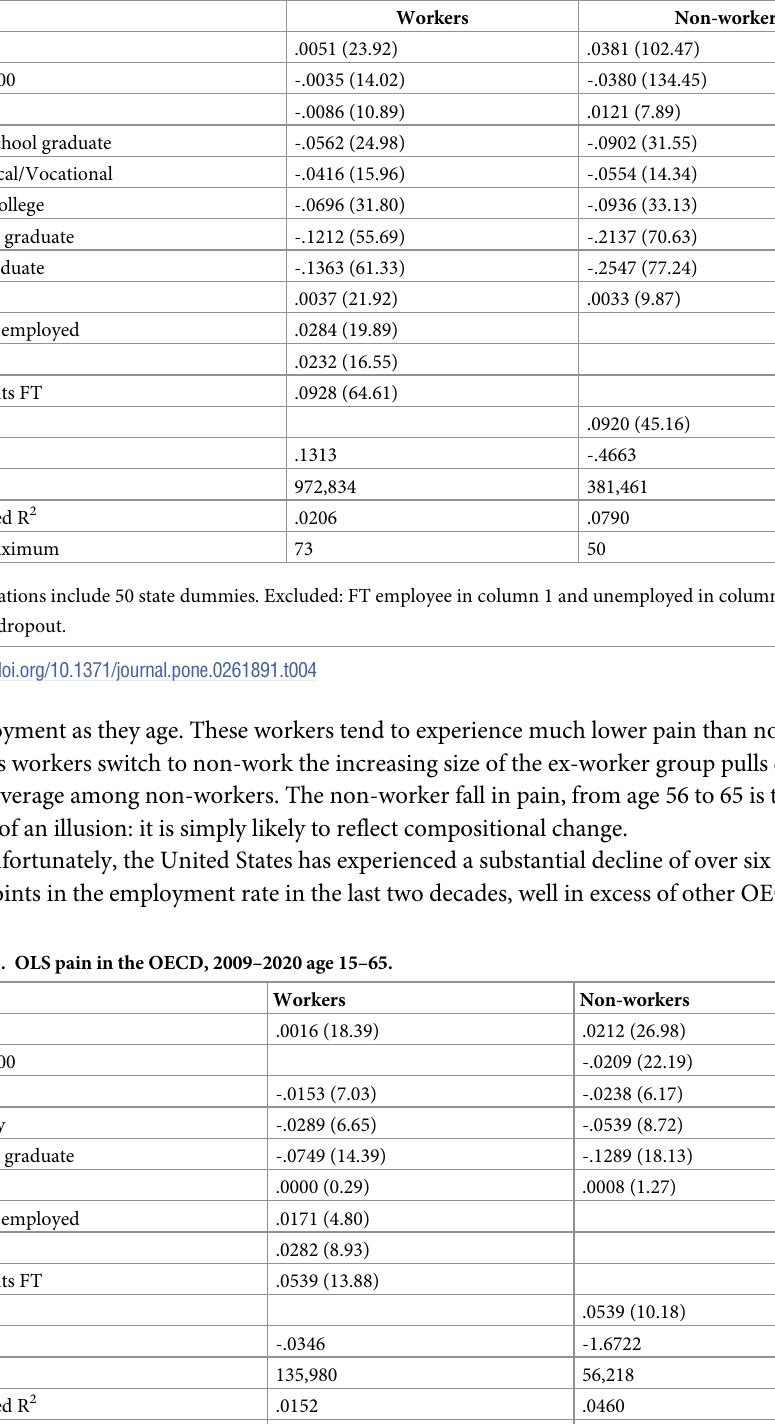
Table 4. OLS pain in the USA, 2009–2017, age 18–65.